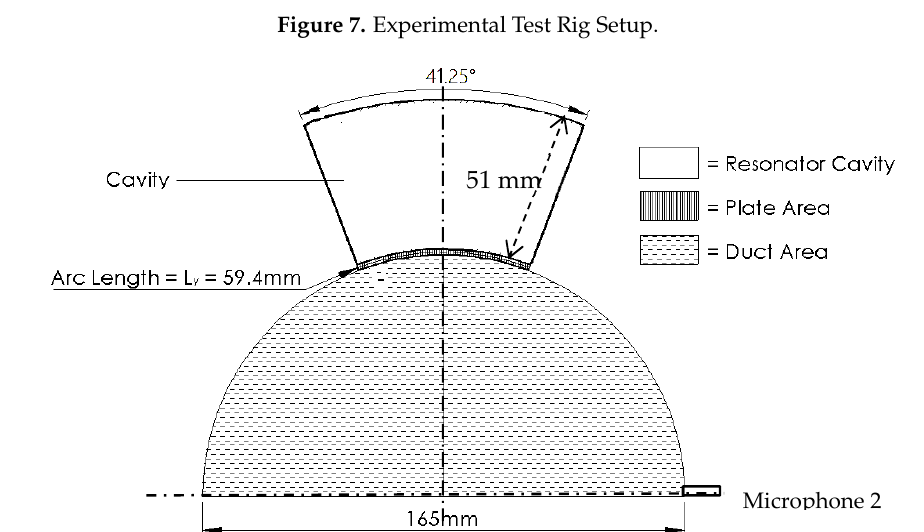
Figure 8. The position and shape of the distributed Helmholtz resonator on the experimental test rig.